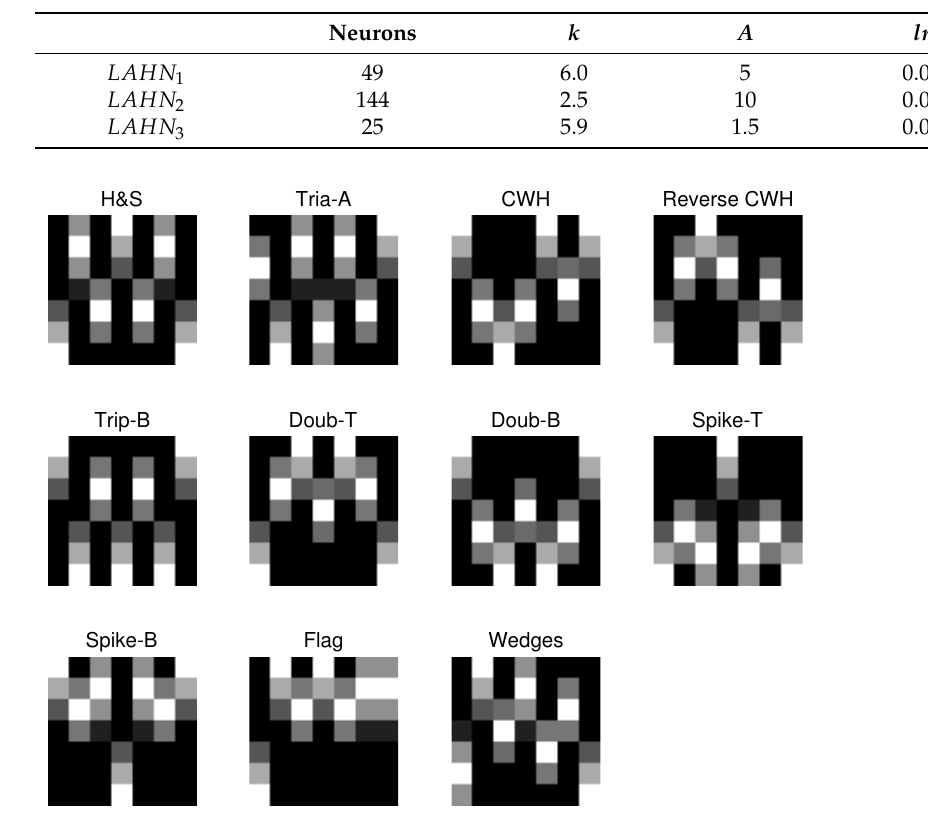
Figure A1. The representation of the